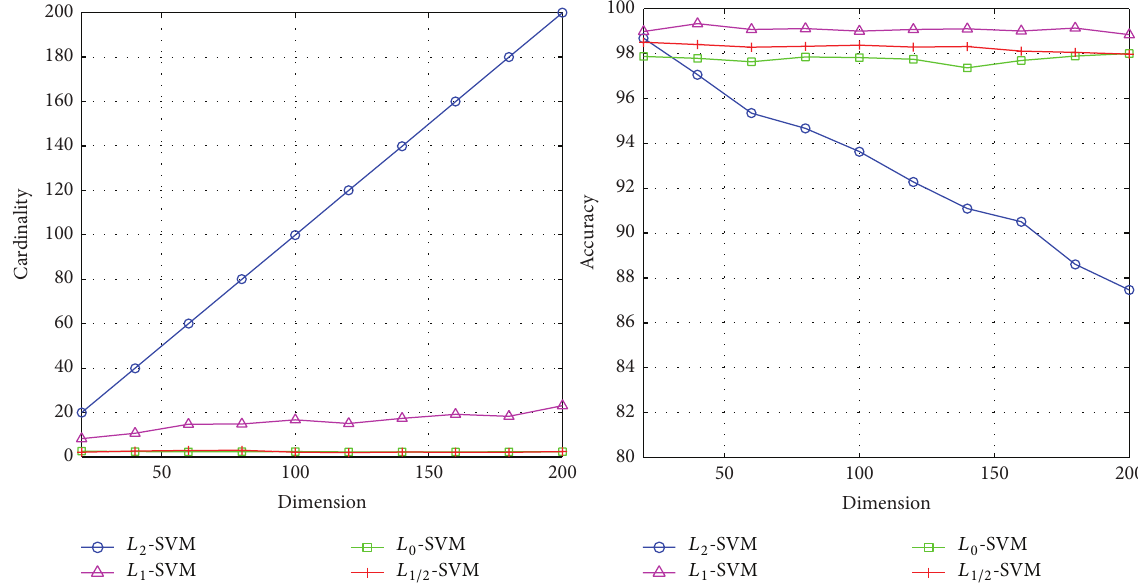
Figure 3: Results comparison on artificial data set with various